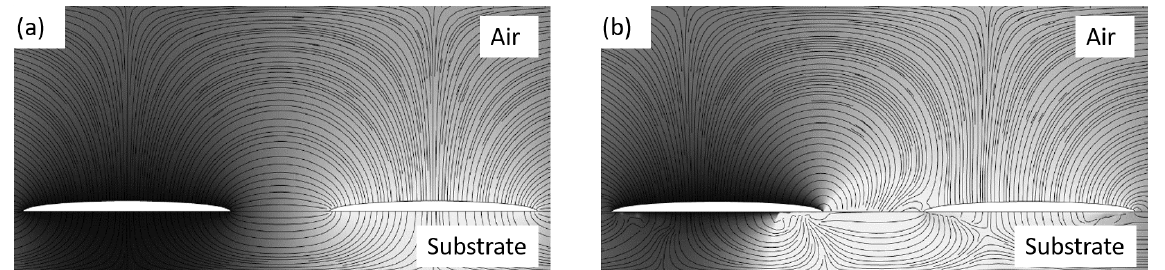
Figure 10. (a) Electric field simulation without the assumption of mobile charge carriers. (b) Electric field simulation with the assumption of sodium and oxygen as mobile charge carriers. The mass transport follows the Nernst–Planck